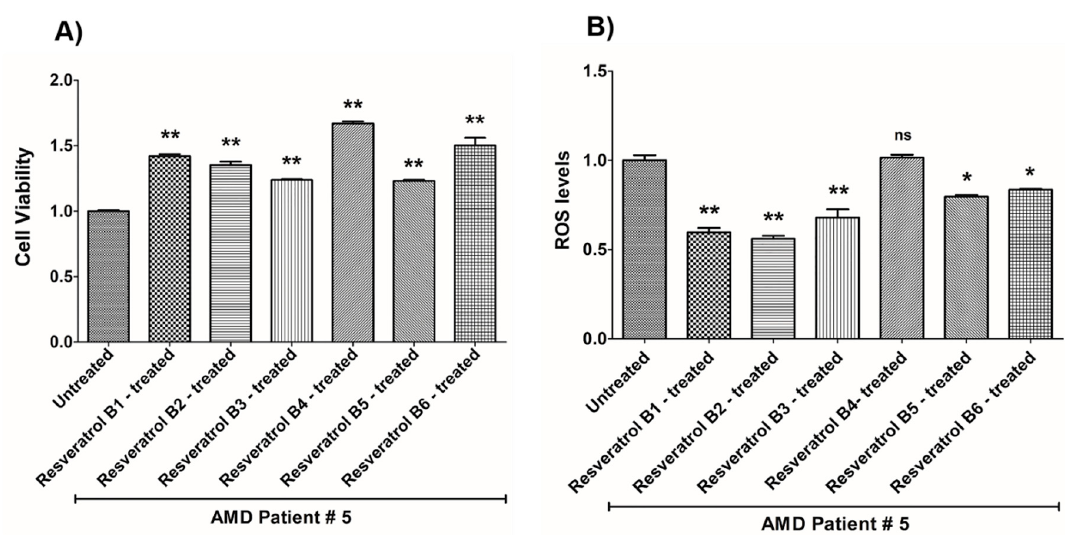
Figure 5. Effects of resveratrol formulations on cell viability ( A ) and ROS levels ( B ) in AMD patient #4. Bar 1—untreated AMD cells; Bar 2—resveratrol B1-treated AMD cells; Bar 3—resveratrol B2- treated AMD cells; Bar 4—resveratrol B3-treated AMD cells; Bar 5—resveratrol B4-treated AMD cells;